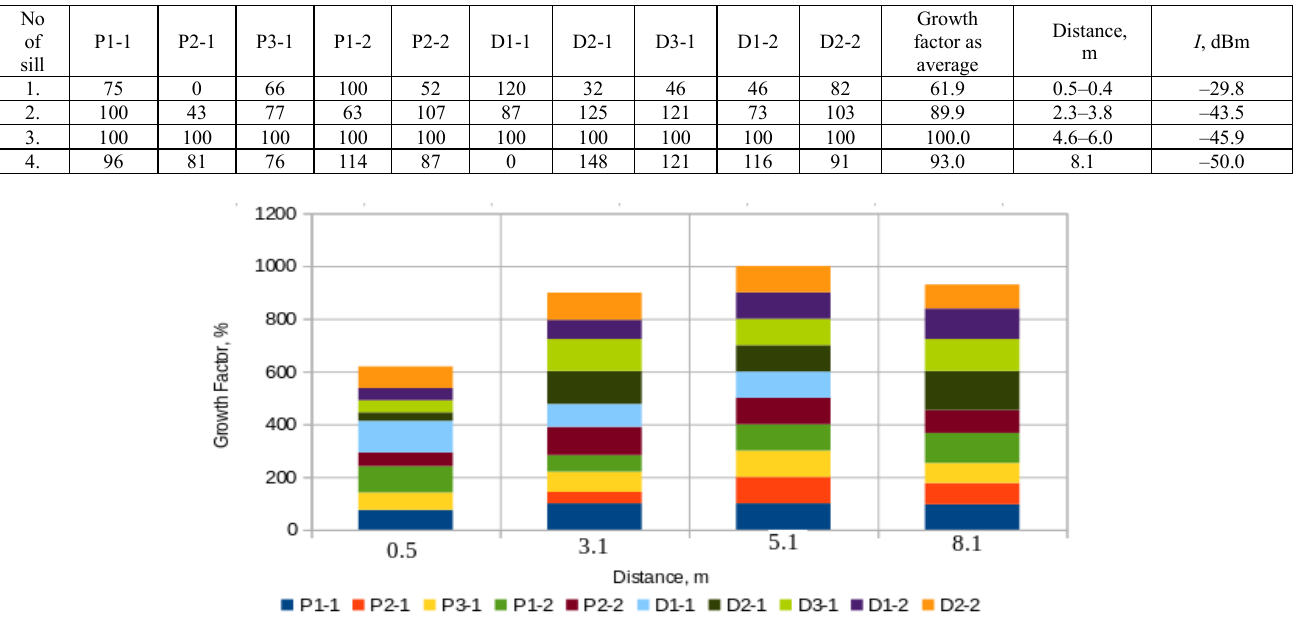
Fig. 1. Growth factor as the sum of intermediate results depending on distance to